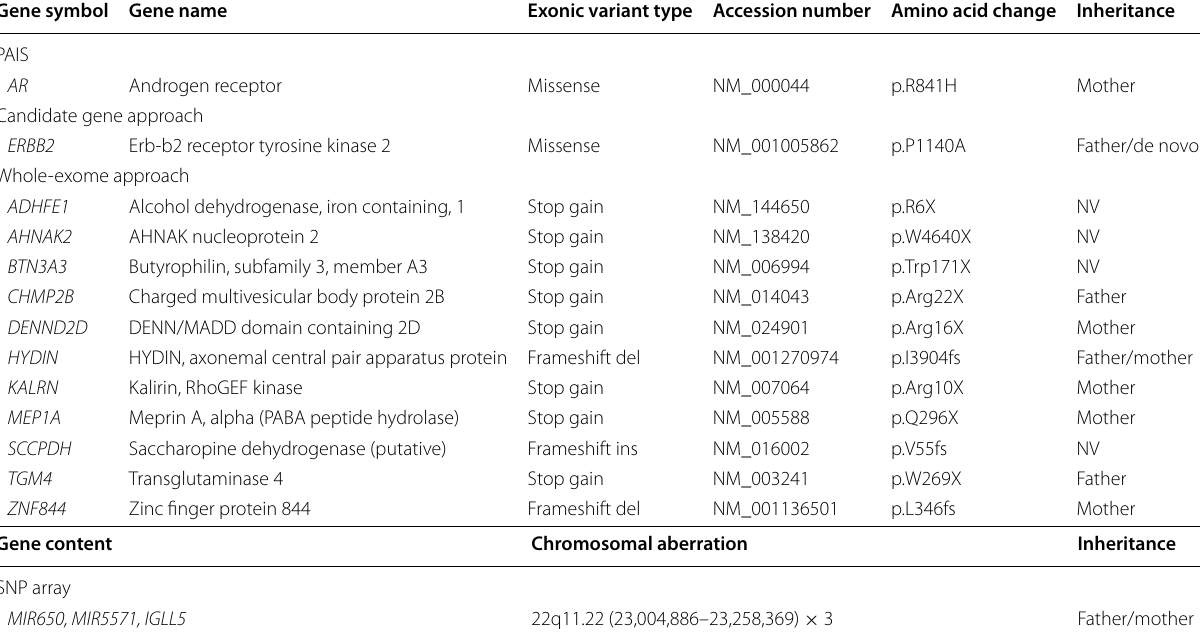
Table 5 Summary of the characteristics of genes connected in the “Gene expression, cellular growth and proliferation, tissue development”